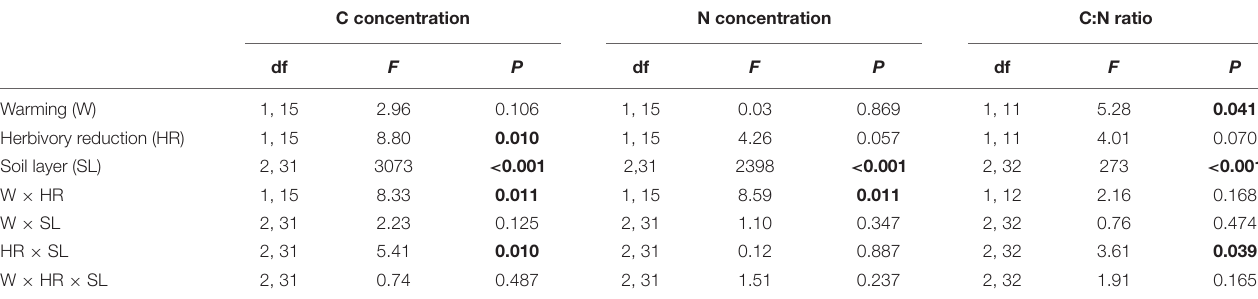
FIGURE 2 | C and N concentrations and C:N ratio of soil layers under Subarctic field layer vegetation growing in ambient or +3 ◦ C temperature and with either natural or reduced insect herbivory. The mean and SE values are estimated marginal means and SE values ( n = 5) produced by the fitted statistical models and were back-transformed from log-transformed data for C concentration and from square root-transformed data for N concentration and C:N ratio. TABLE 3 | F and P statistics of the effects of warming (ambient, +3 ◦ C), herbivory reduction (normal, reduced) and soil layer (organic soil, 0–5 cm mineral soil, > 5 cm mineral soil), on soil C and N concentrations and C:N ratio under forest field layer vegetation (block was included in the models as a random factor and the initial soil NH 4 + concentration as a covariate, but these effects are not reported; P < 0.05 are in